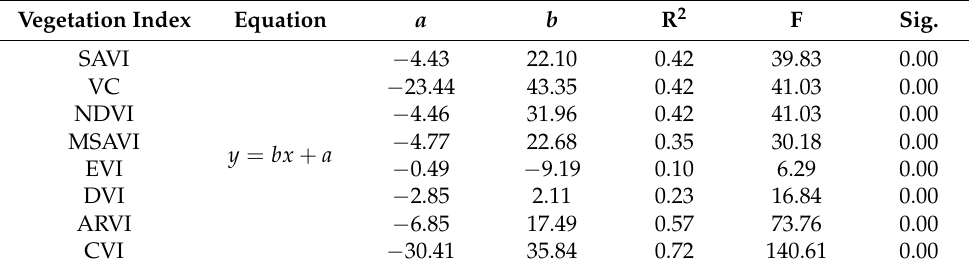
Table 3. The statistics of 3D-GSQ in the urban area of